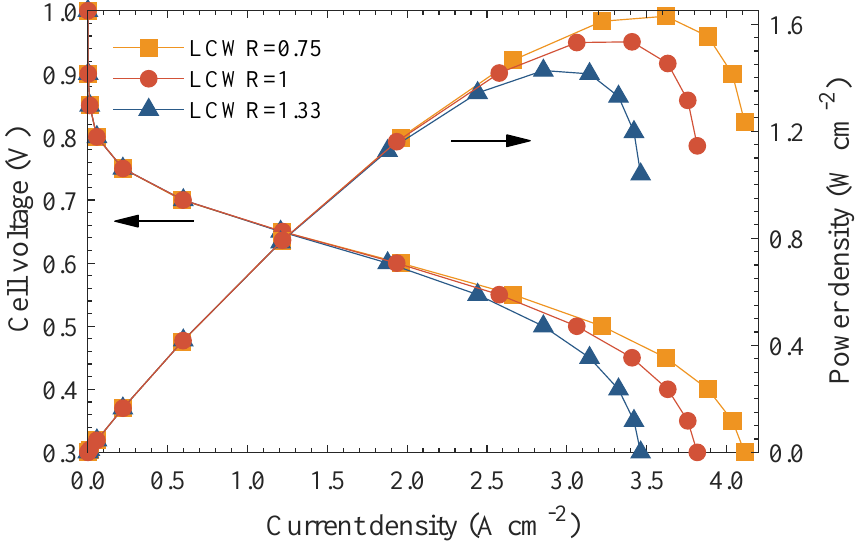
Figure 11. Comparison of the cell performance of PEMFCs cooled by HPBPs with different LCWRs. The effect of LCWR variation on the heat and mass transport phenomena in